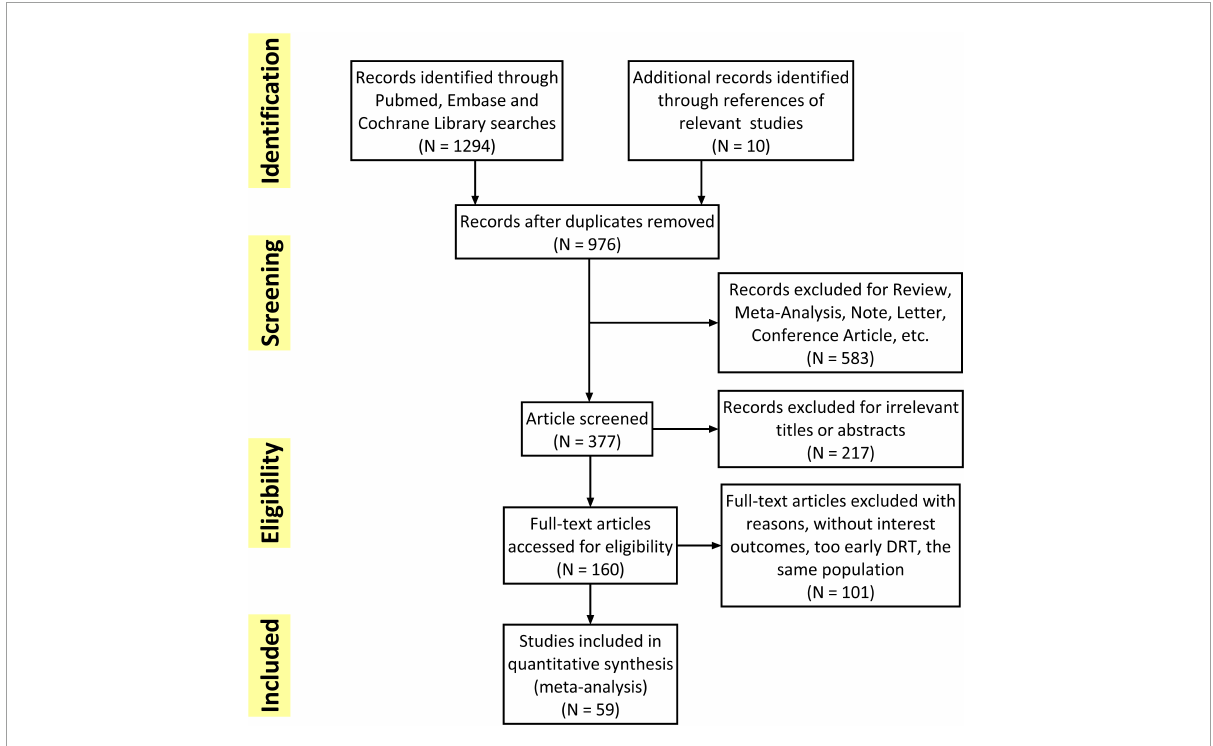
FIGURE1 Flowchart of eligible